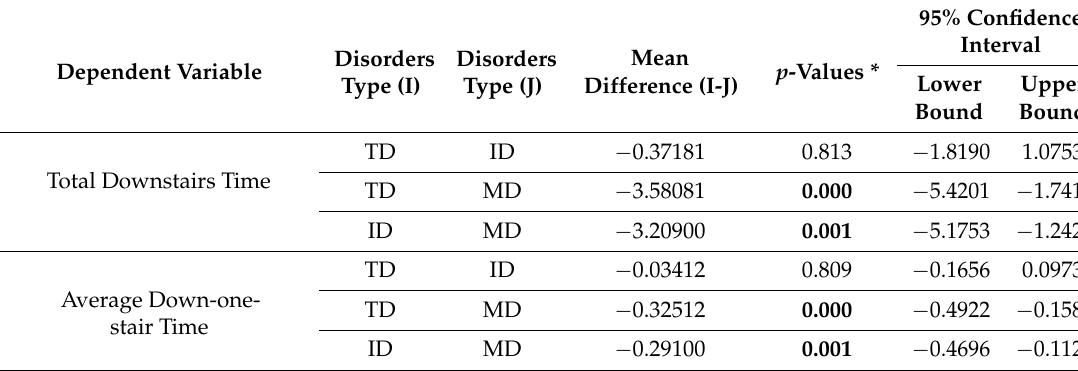
Table 6. Post hoc tests of downstairs walking for the three